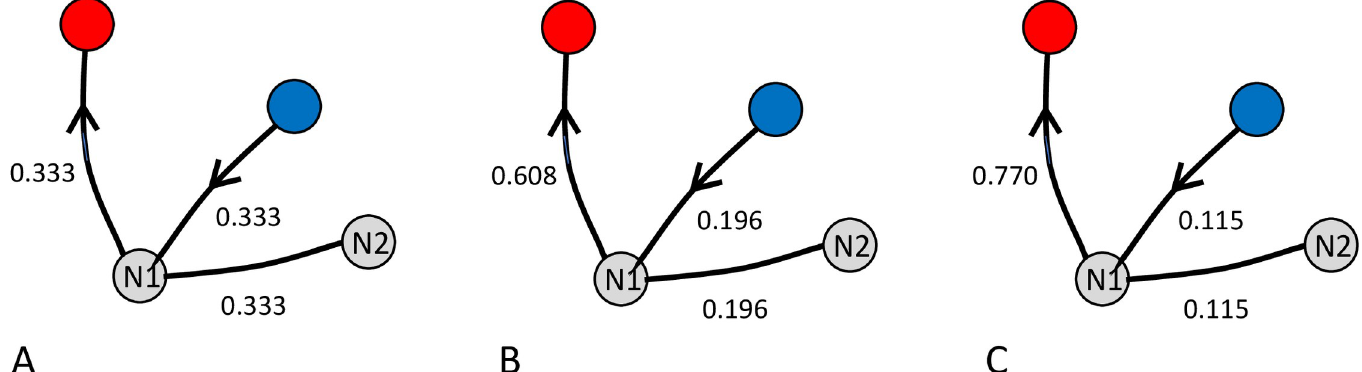
Fig 8. Illustration of update rule in the rewarded-choice model. A) At node N1, the default likelihoods for the three potential choices are 1/3 each. Each time the participant chooses the (successful) path from N1 to R (arrows) the likelihoods for the chosen route is increased in the model according to the rule p text), where the learning coefficient, α , is 0.7 in these examples. The other two routes are updated according to the rule p likelihoods shown in B. When the participant chooses the route N1 to R again, the same rules give rise to the likelihoods shown in C.